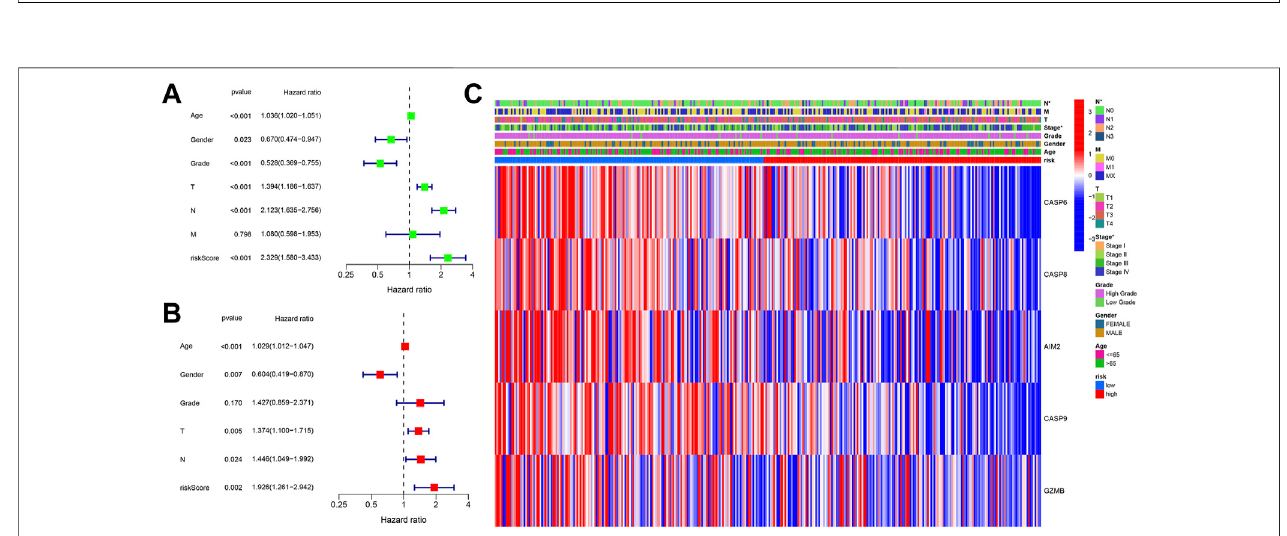
FIGURE 4 | (A) PCA plot shows the distribution of high-risk and low-risk groups. (B) Distribution of the survival status for the high-risk and low-risk groups. (C) Kaplan – Meier curves of OS for the high-risk and low-risk groups ( p = 0.006). (D) ROC curves of 1, 3, and 5 years for the risk